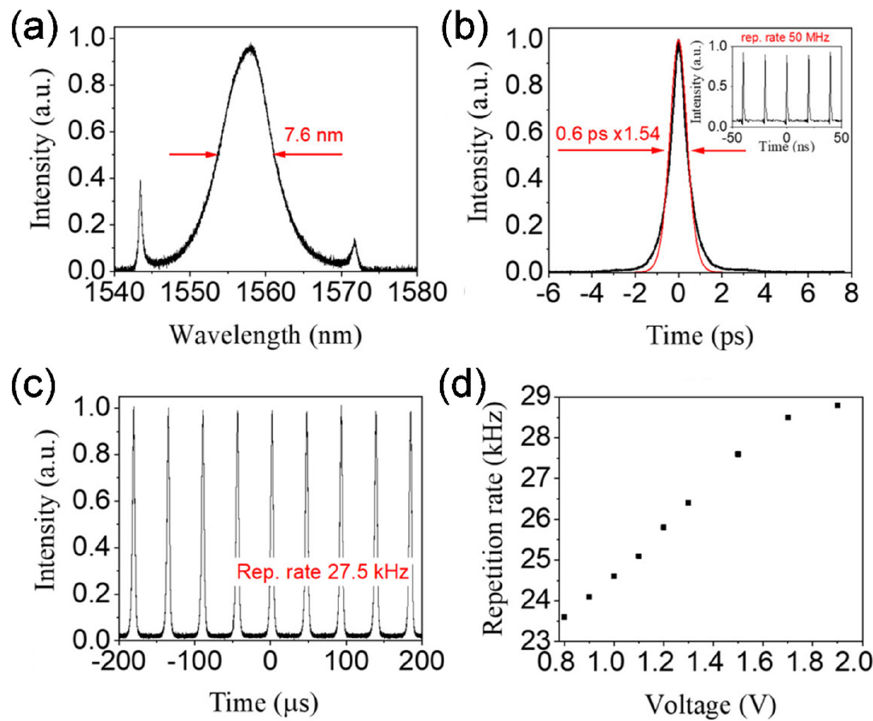
Figure 12. Electrically controlled fiber laser using SWCNT SA device and gate-variable properties of fiber laser operation. Soliton ML fiber laser characteristics at V G = 0 V: ( a ) optical soliton pulse spectrum shows the 3 dB bandwidth of 7.6 nm, ( b ) autocorrelation trace shows the pulse duration of 600 fs with oscillation trace (inset showing repetition rate of 50 MHz) of the mode-locked pulse. QS fiber laser characteristics at V G > 0.7 V: ( c ) oscillation trace of QS pulse with repetition rate of 27.5 kHz, ( d ) variation of QS pulse frequency as a function of applied gate voltage showing that, repetition rate is controlled in the range from 23.6 kHz to 28.8 kHz with applied gate voltage V G varying from 0.8 V to 1.9 V. Reproduced with permission. Copyright 2019, American Chemical Society